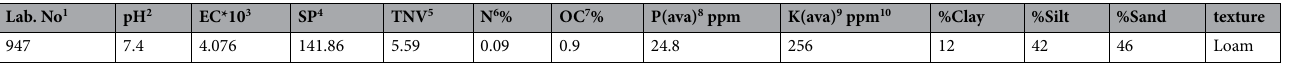
Table 1. The soil physical and chemical analysis. 1. Laboratory Number, 2. Power of Hydrogen, 3. Electrical Conductivity, 4. Saturation Percentage, 5. Total Neutralizing Value, 6. Nitrogen, 7. Organic carbon, 8. Phosphorus, 9. Potassium, 10, part per